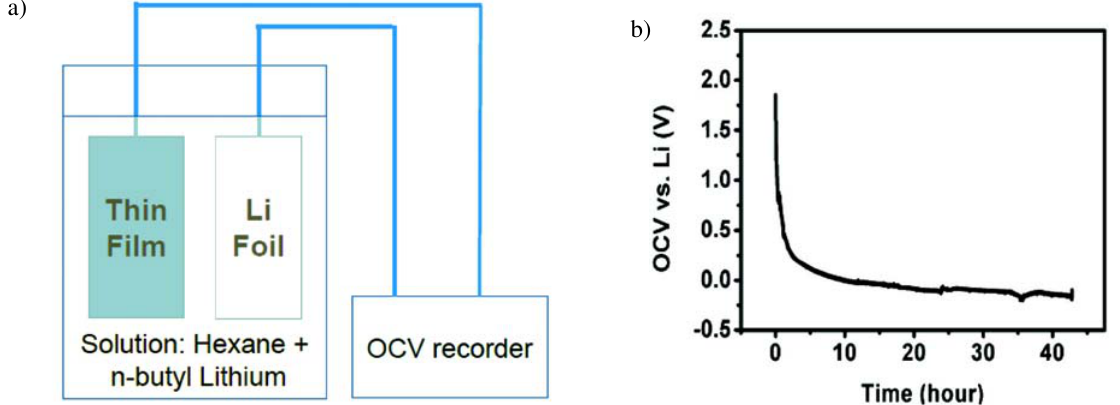
Figure 6. (a) The scheme of the chemical lithiation process and the tracking method for monitoring the lithiation level. (b) The recorded voltage of the cell during chemical